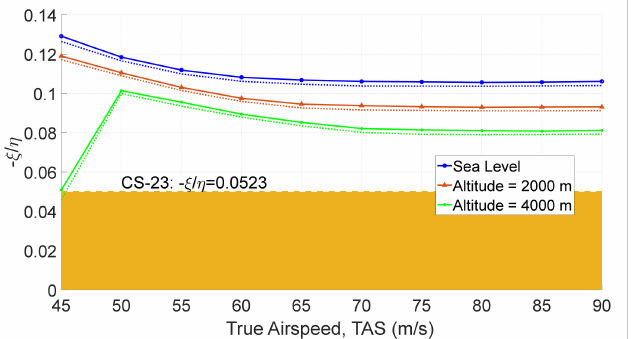
Figure 16. Dutch roll criteria according to the CS-23 requirements; (solid lines account for optimiza- tion using mass minimization scenario and dotted-lines are for drag optimization in trim